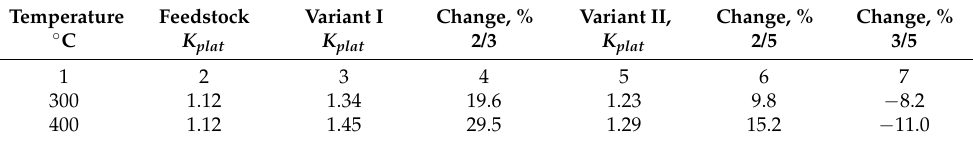
Figure 7. Values of K plat coefficient depending on the rolling conditions. The data presented in Figure 7 show that the developed new system of modified passes (variant II) had a positive effect on the thickness distribution of the Al layer. In each of the analyzed rolling variants, there was an increase in the unevenness of the plating layer distribution in relation to the feedstock after explosive welding; however, during rolling at the temperature of 300 ◦ C with the use of modified grooves, the most even plating thickness distribution was obtained. For explosive welding, components in the form of AZ31 bars and Al tubes with perfect geometry were used. Thus, K plat coefficient, marked by the uneven distribution of the plating layer, was close to 1 ( K plat = 1.12). Due to the fact that rolling in passes is marked by a spatial state of deformation and the lack of possibility to fully control the flow of the bimetallic band, it is natural that K plat for bimetallic bars, after rolling in grooves, will increase in relation to the bimetallic feedstock. The modification of the shape of the passes, consisting of replacing the single-radius surface with multi-radial surfaces with straight sections, had a positive effect on the change in the deformation distribution and the evenness of the plastic flow of individual components in the Mg/Al bimetallic bar during rolling in the rolling gap (variant II). The new shape of the grooves enabled us to limit the accumulation of the plating layer material at the ends of the grooves towards the horizontal axis of the pattern symmetry and to reduce the thinning of the layer towards the bending at the same time. Thus, regardless of the rolling temperature, K plat coefficient increased to a smaller extent in variant II in relation to Mg/Al bimetallic bars rolled in the classic system of passes (variant I). Rolling bars at the temperature of 300 ◦ C, regardless of the applied rolling variant, had a positive effect on the evenness of deformation and plastic flow of the bimetal components. Thus, for Mg/Al bars rolled at 300 ◦ C, K plat coefficient was lower compared to the bars rolled at 400 ◦ C. The most even distribution of the plating layer was obtained for Mg/Al bars rolled in passes modified for the rolling temperature of 300 ◦ C. Detailed changes of K plat coefficient for individual rolling variants are presented in Table 3. Table 3. Change of K plat coefficient in Mg/Al bars after rolling in